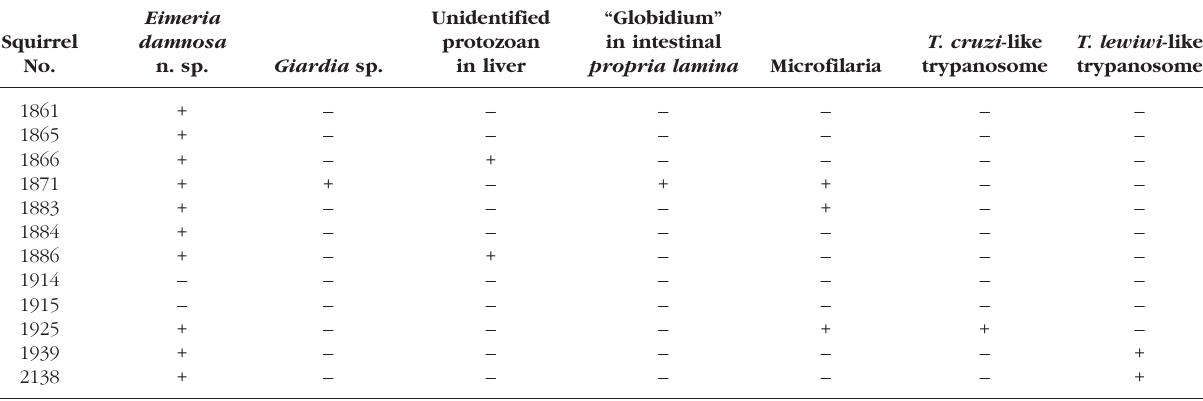
Table I. – Parasites encountered in 12 specimens of the Amazonian red squirrel Sciurus spadiceus